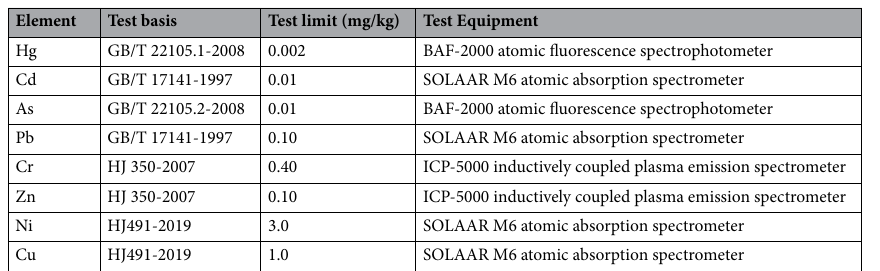
Table 1. Executive standard for test of heavy metal